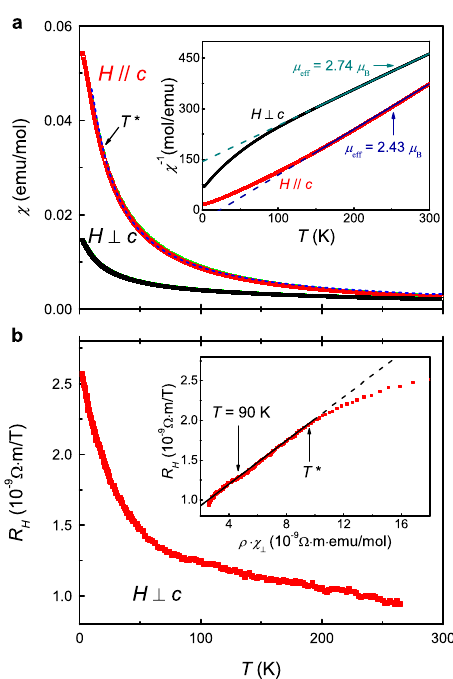
Fig. 5 Temperature dependence of the susceptibility and Hall coef fi cient. a The FC ( red and black ) and ZFC ( green ) susceptibility of CeCo 2 Ga 8 along ( χ || ) and perpendicular ( χ ⊥ ) to the c -axis. The dashed line is the fi t to χ || using the formula of 1D spin chain. The inset shows the the Curie – Weiss fi t ( dashed lines ) to the inverse susceptibility, yielding μ eff = 2.74 μ B for H ⊥ c and μ eff = 2.43 μ B for H || c at high temperatures. b The Hall coef fi cient ( H ⊥ c , j || c ) as a function of temperature. The inset compares the Hall coef fi cient with the prediction ( dashed line ) of the skew scattering